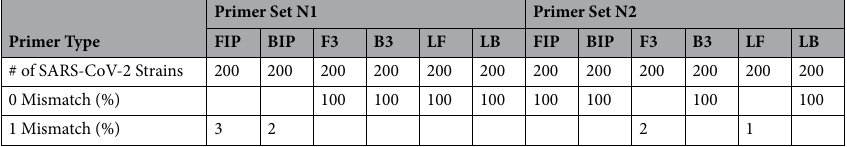
Table 5. In silico inclusivity analysis with SaliVISION multiplex primer set targeting N gene of SARS-CoV-2